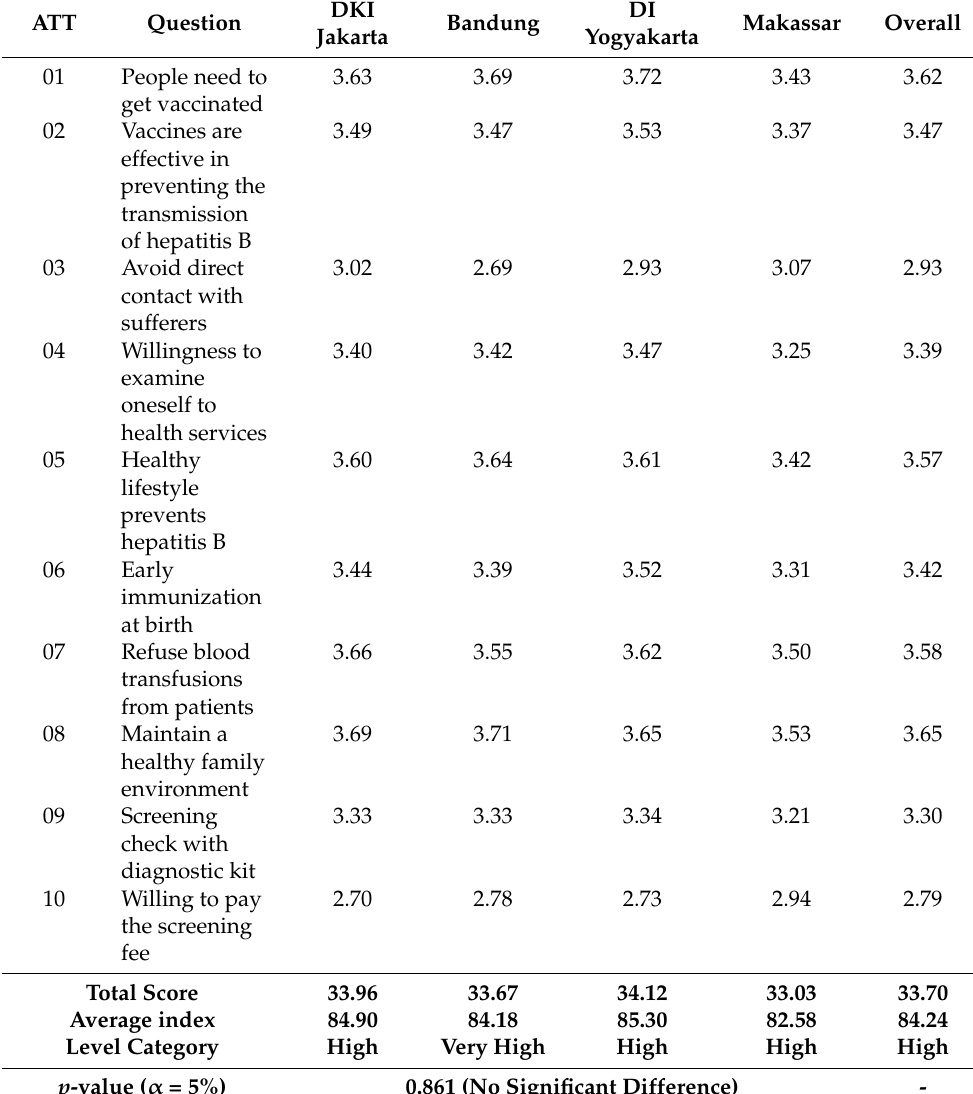
Table 4. Positive attitude level on hepatitis B prevention among respondents. ATT Question